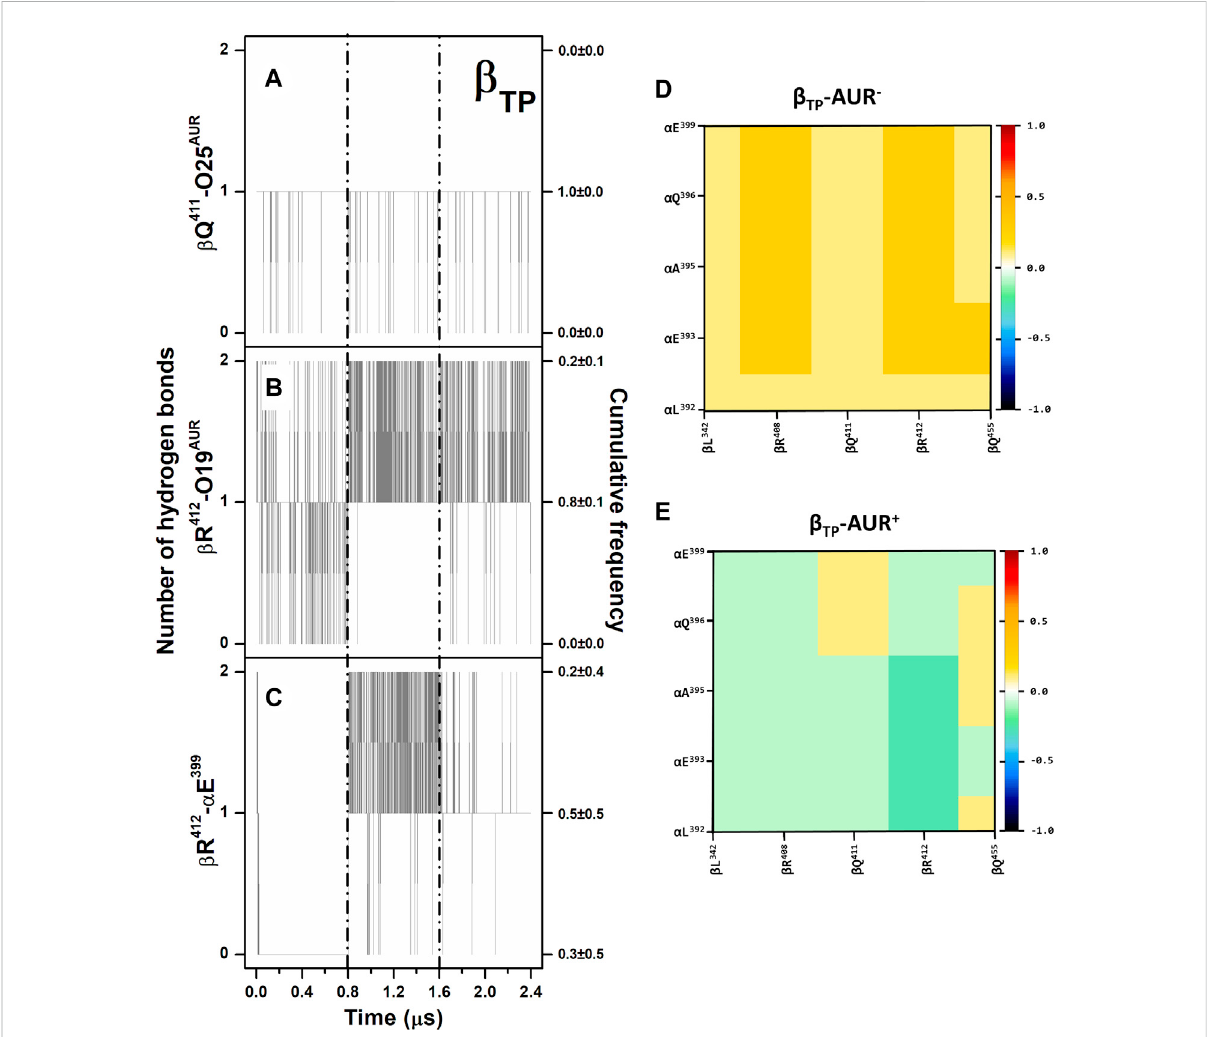
FIGURE 3 Hydrogen bonding in β TP -AUR+ and correlated motions of α TP and β TP CTD residues. (A and B) Protein-inhibitor hydrogen bonds. (C) α TP - β TP hydrogen bond. Data for the three concatenated 1-µs replicas are shown, after subtracting the fi rst 0.2 µs of simulation from each one. The trajectories of each replica are delimited by dashed lines. Cumulative frequencies refer to the total fraction of time each number of hydrogen bonds was observed in the simulations. (D and E) Dynamic cross-correlation maps of α TP and β TP CTD residues, calculated over side chain atoms around their mid-positions for 2.4- μ s MD simulations in the absence and presence of